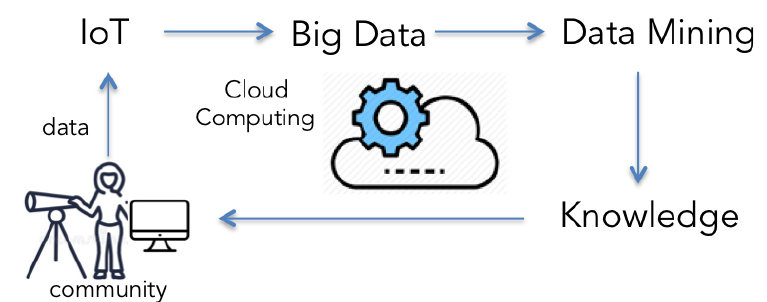
Figure 2. Today, the data life cycle can follow the path defined by data science based entirely on cloud computing. The observer makes use of IoT devices to place their data in the cloud. The IoT is generating Big Data where your data is now inserted. A user can mine the data and extract knowledge directly in the cloud. This knowledge can serve to generate new data and thus boost the